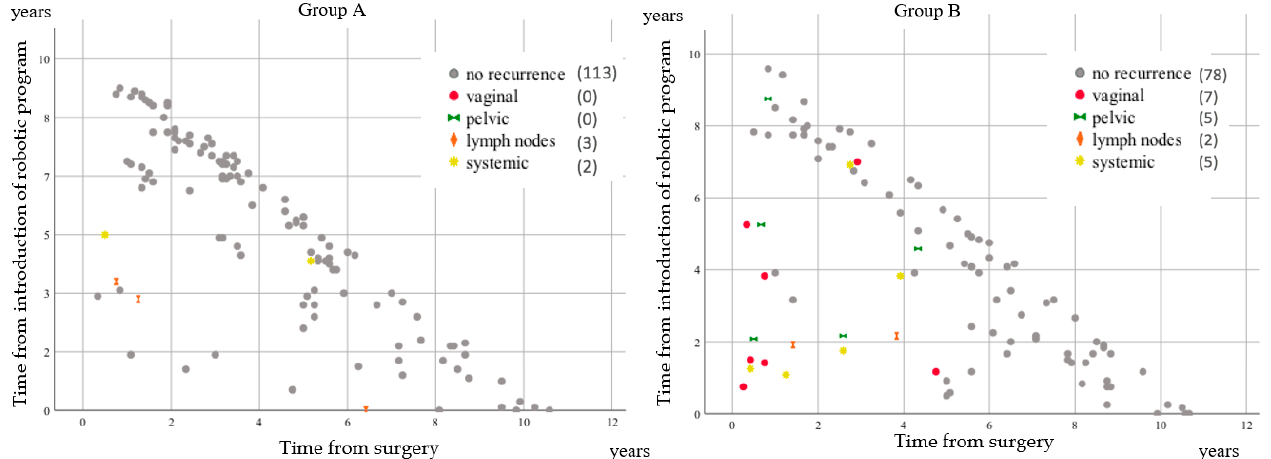
Figure 3. Relationship between the time of recurrence and the time from the introduction of the robotic program. All recurrences (in color) and no events (in gray) in both groups are presented on scatter graphs. Five and 19 recurrences in groups A and B , respectively, are presented in relation to the follow-up period and the time from the introduction of the robotic program.